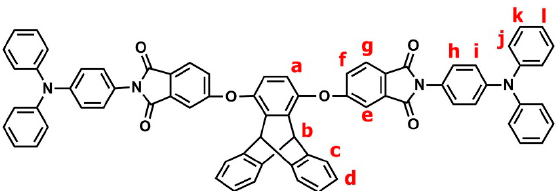
Figure 1. Structure and codes of hydrogen atoms of triphenylamine triptycene diimide (TPA-TPDI).